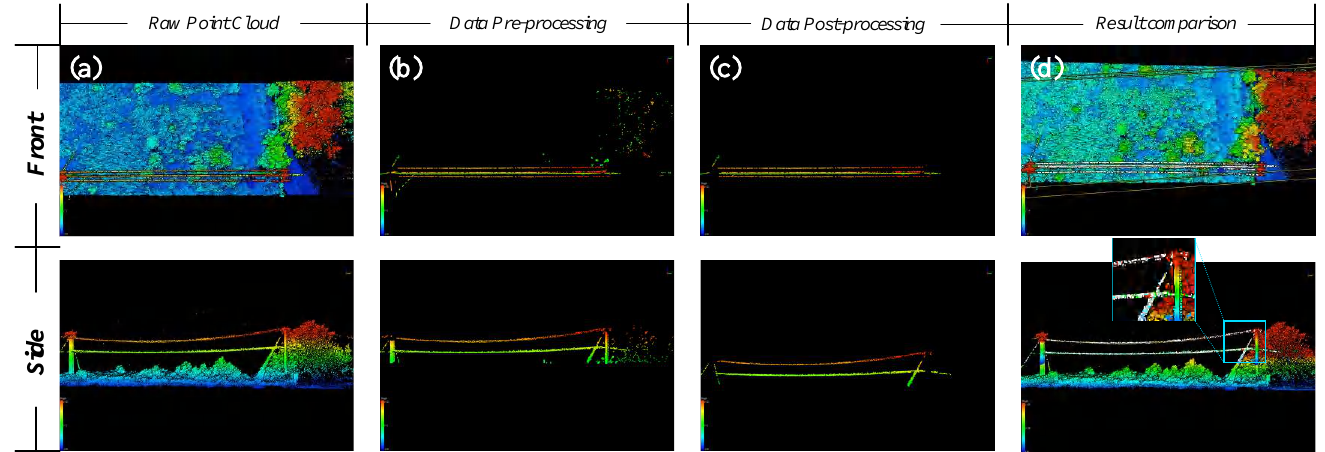
Figure 4. There are the front and side views of the first set of sample point clouds (order from left to right): ( a ) before segmentation and extraction; ( b ) after preprocessing; ( c ) after completion of segmentation and extraction; and ( d ) the comparison display (marked as white and